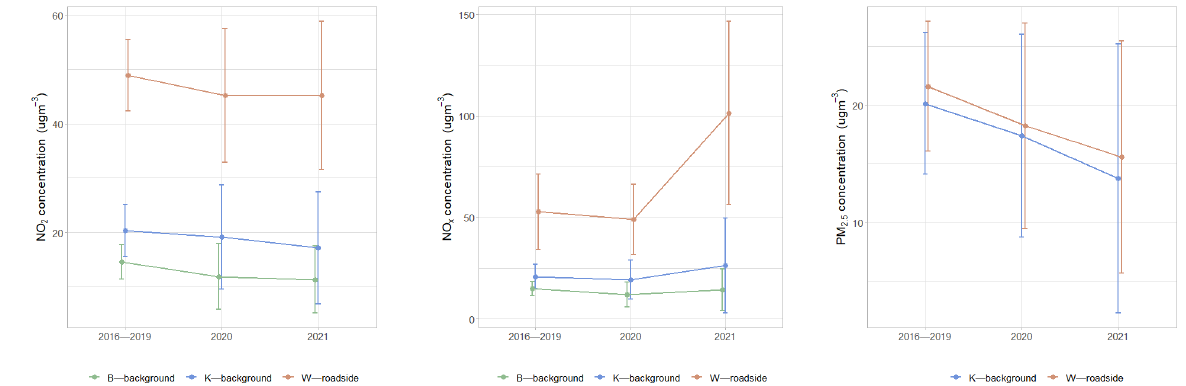
Figure 11. Average values of concentrations of air pollutants in the period 10 March–31 May 31 with standard deviation.